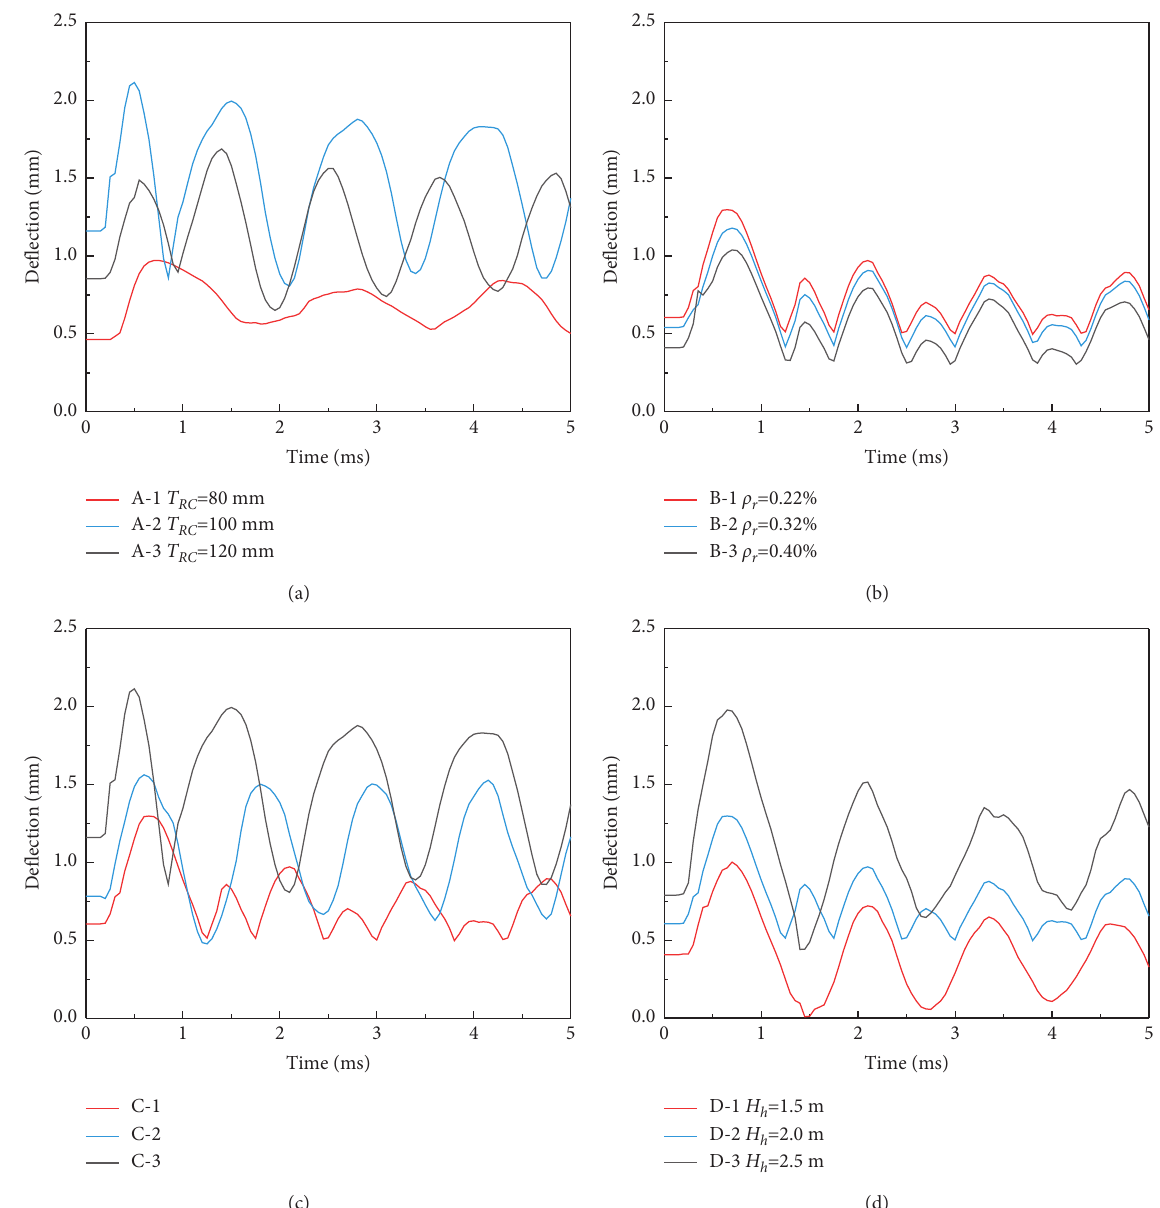
Figure 10: Time history curves of deflection of RC slab under the second